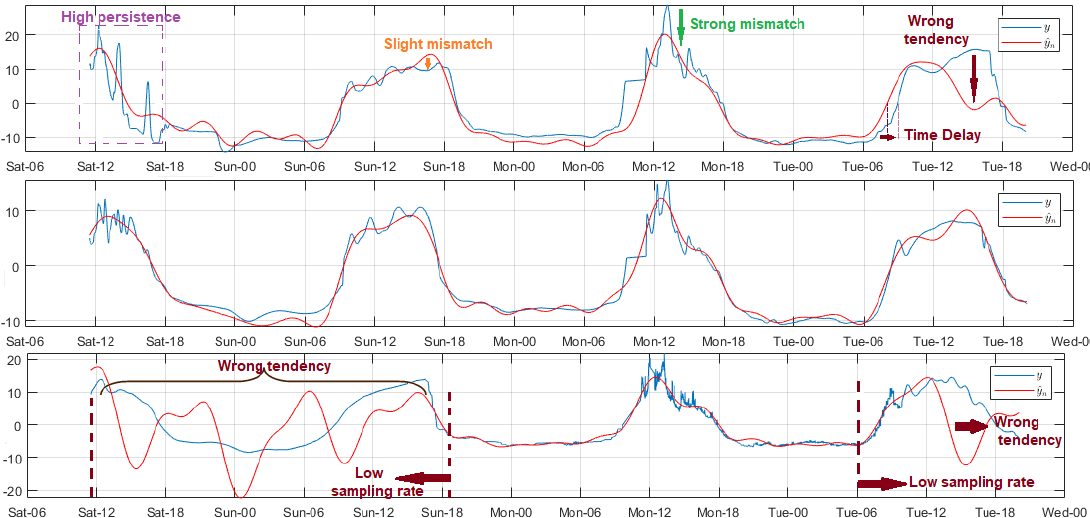
Figure 8. Representative modeled signals of air temperature. From top to bottom: Node 3 of DigiMesh network with Reg = 1, Node 2 of ZigBee network with Reg = 3, and Node 2 of WiFi network with Reg =